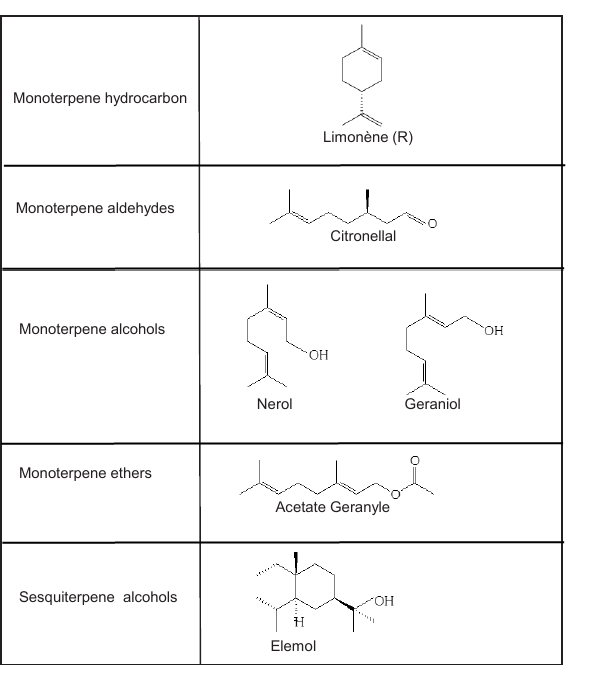
Bayala et al. , Figure 1.